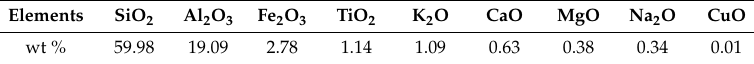
Table 2. Chemical composition of fly ash (FA) in wt